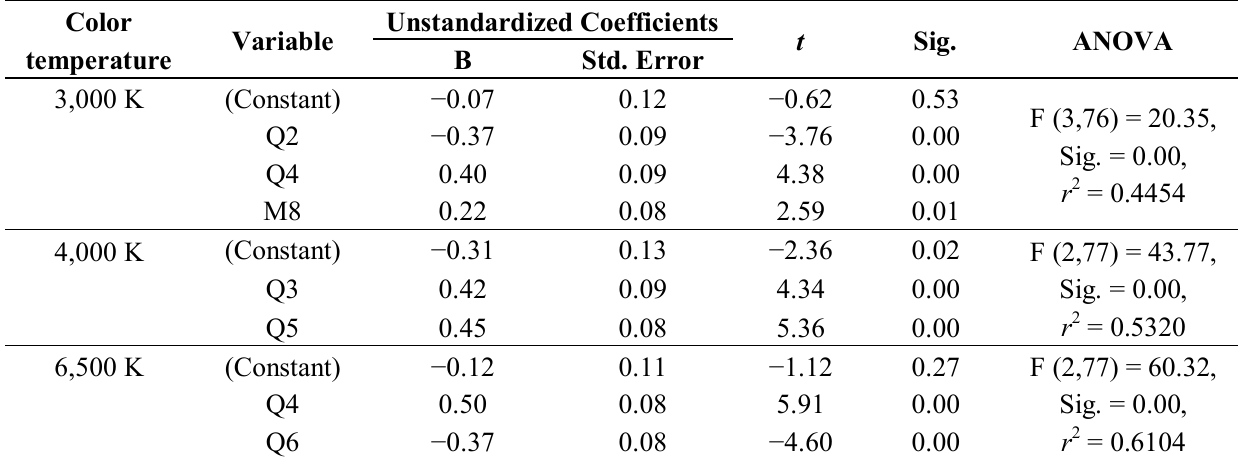
Table 6. Prediction model of mood for lighting environment (mood: pleasant/unpleasant). Color